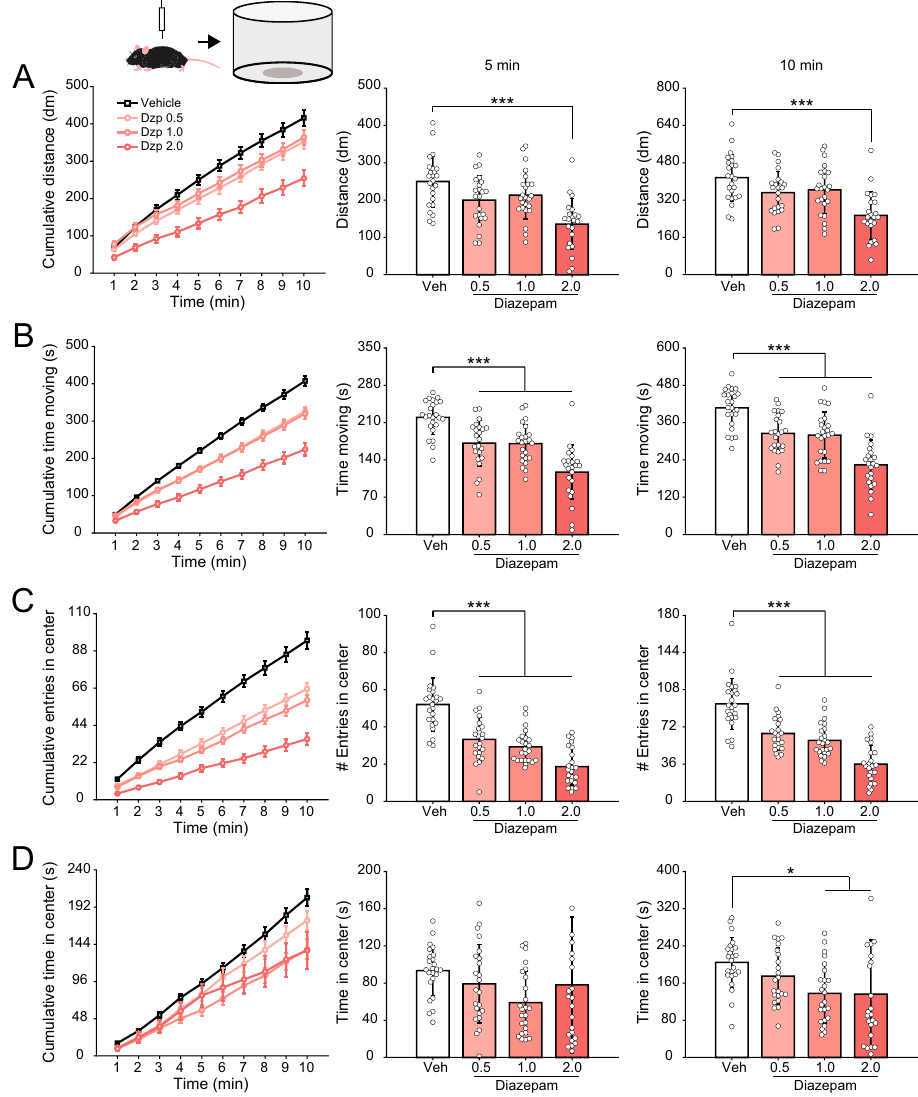
Figure 4. Diazepam effects in the open field. ( A ) (Left) Cumulative distance moved in the open field. (Middle and right) Mean (± SD) distance after 5 (middle) and 10 min (right). White circles show data for individual animals. Animals were injected i.p. with vehicle or three doses of diazepam (0.5, 1.0 and 2.0 mg/kg) thirty minutes prior to behavior testing, as labeled. ( B – D ) As before, but for the time spent moving ( B ), number of entries in the center zone ( C ) and time spent there ( D ). Diazepam reduced locomotor activity and the number of entries in the center zone. *p < 0.01, ***p < 0.0001, one-way ANOVA followed by Tukey’s post hoc